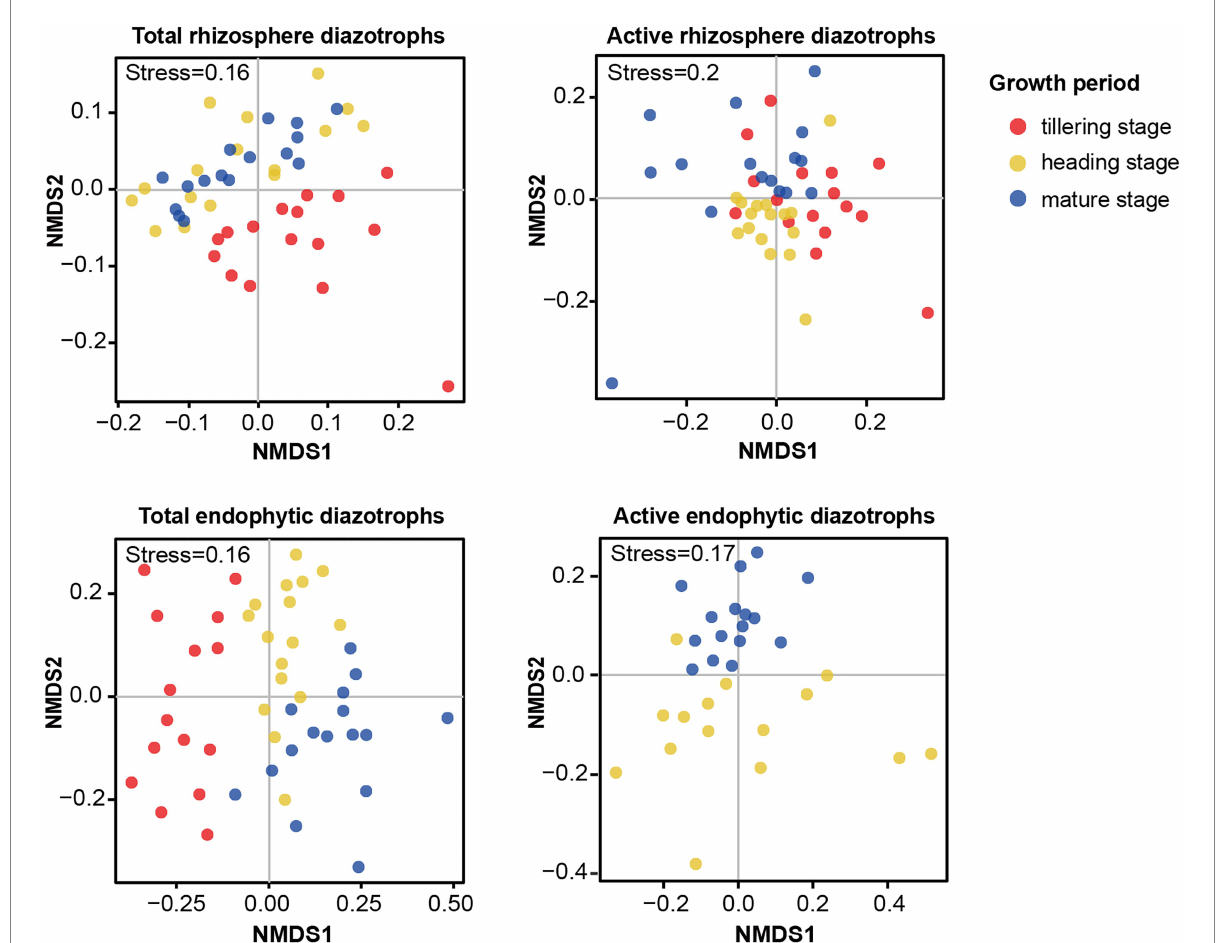
FIGURE 3 Effects of growth period on the community composition of total and active root-associated diazotrophs in 2016. NMDS ordinations based on the Bray–Curtis distance matrix of diazotrophic communities in each microhabitat at the DNA and RNA levels in